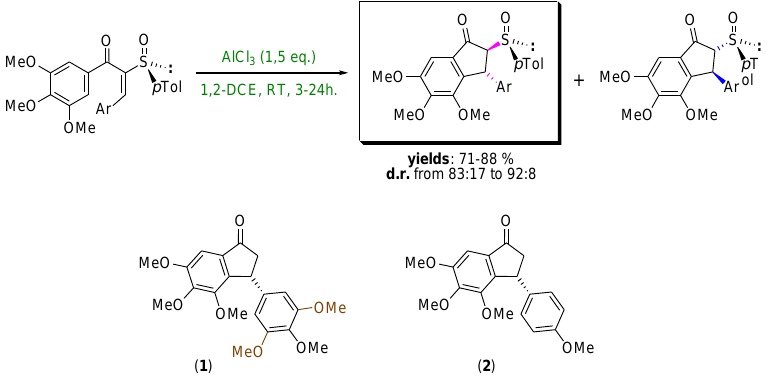
Figure 41. Torquoselective Nazarov cyclization and anticancer agents 1 and 2